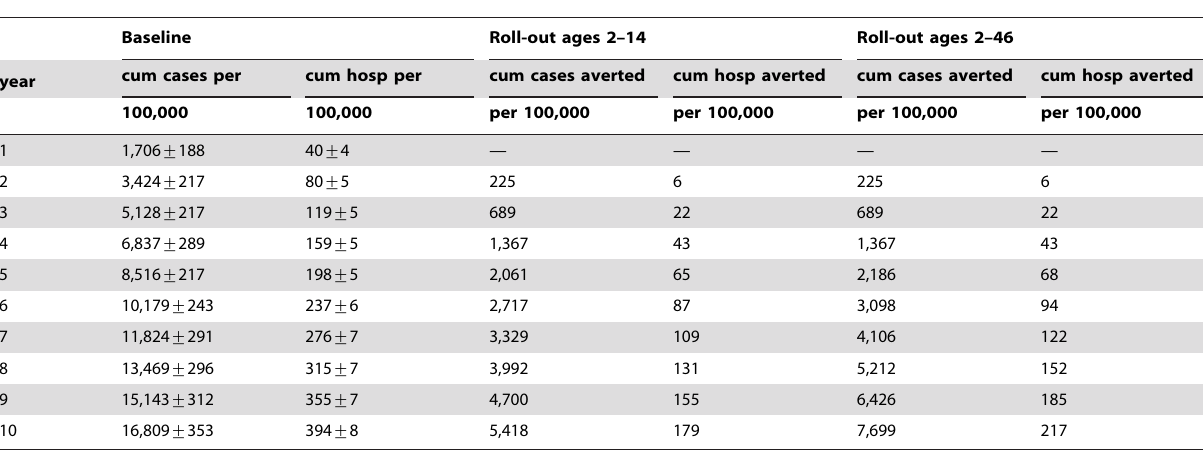
Table 2. Multi-year dengue simulation